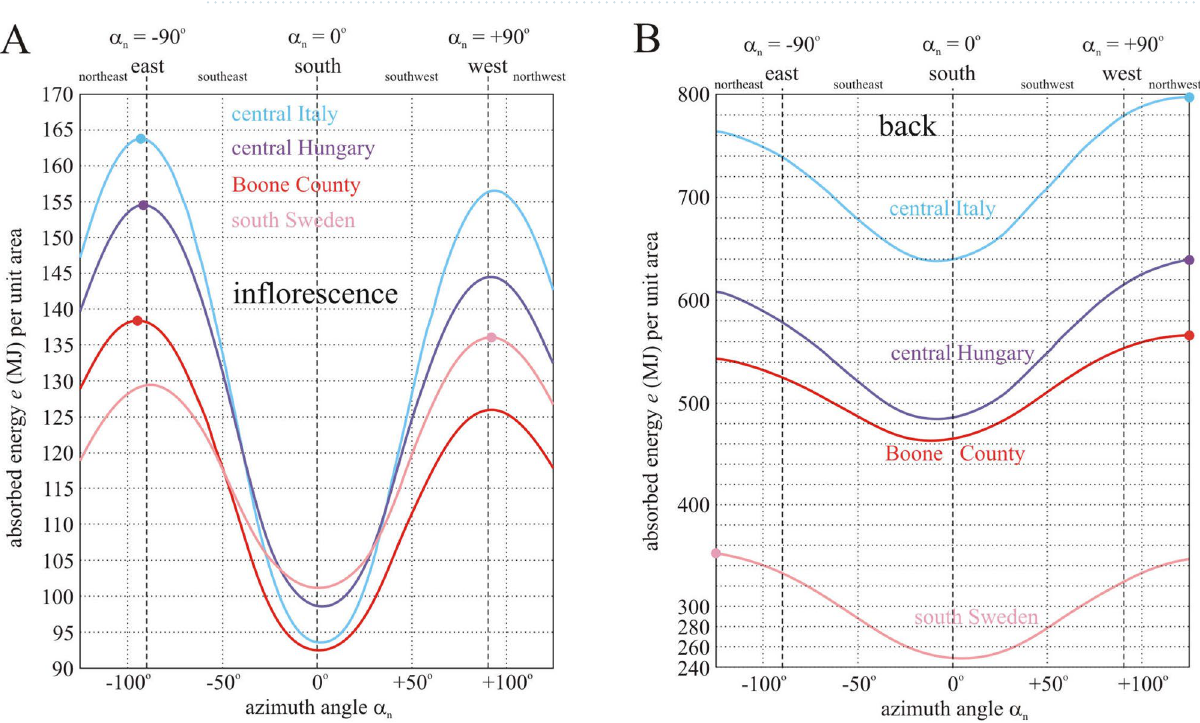
Figure 5. Light energy absorbed by a sunflower head versus its azimuth direction. Total energy e per unit area absorbed by the inflorescence ( A ) and the back ( B ) of a mature sunflower head between anthesis (1 July) and senescence (7 September) as a function of the azimuth angle α n of the head’s normal vector computed for Boone County, central Italy, central Hungary, and south Sweden. The primary maxima of curves are indicated by